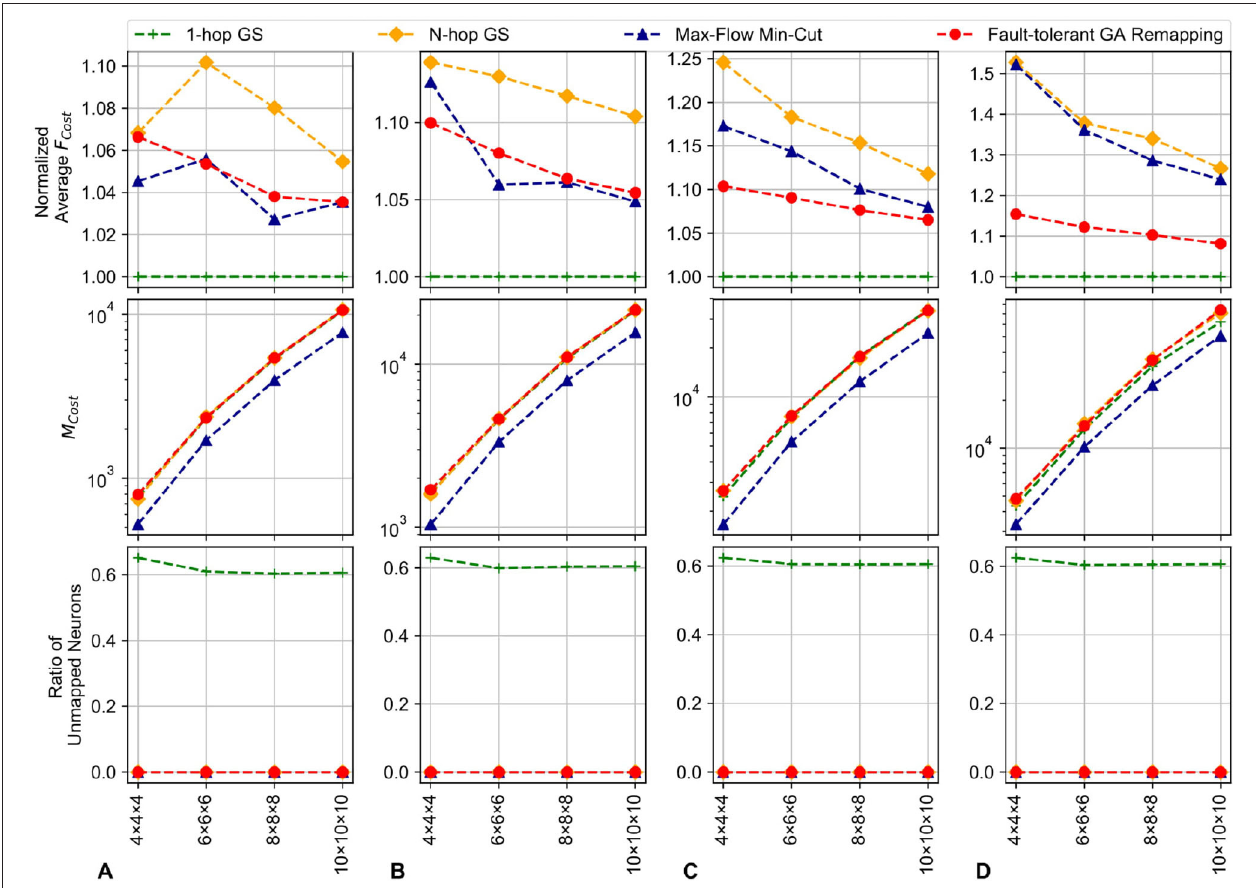
FIGURE 15 | Output mapping for the migrated neurons with random fault patterns in 3D-NoCs. The system has 256 neurons per node; 20% of the neurons are spares with 1 redundant node without any allocated neuron at 0% fault rate. (A) 5% defect rate. (B) 10% defect rate. (C) 15% defect rate. (D) 20% defect rate.